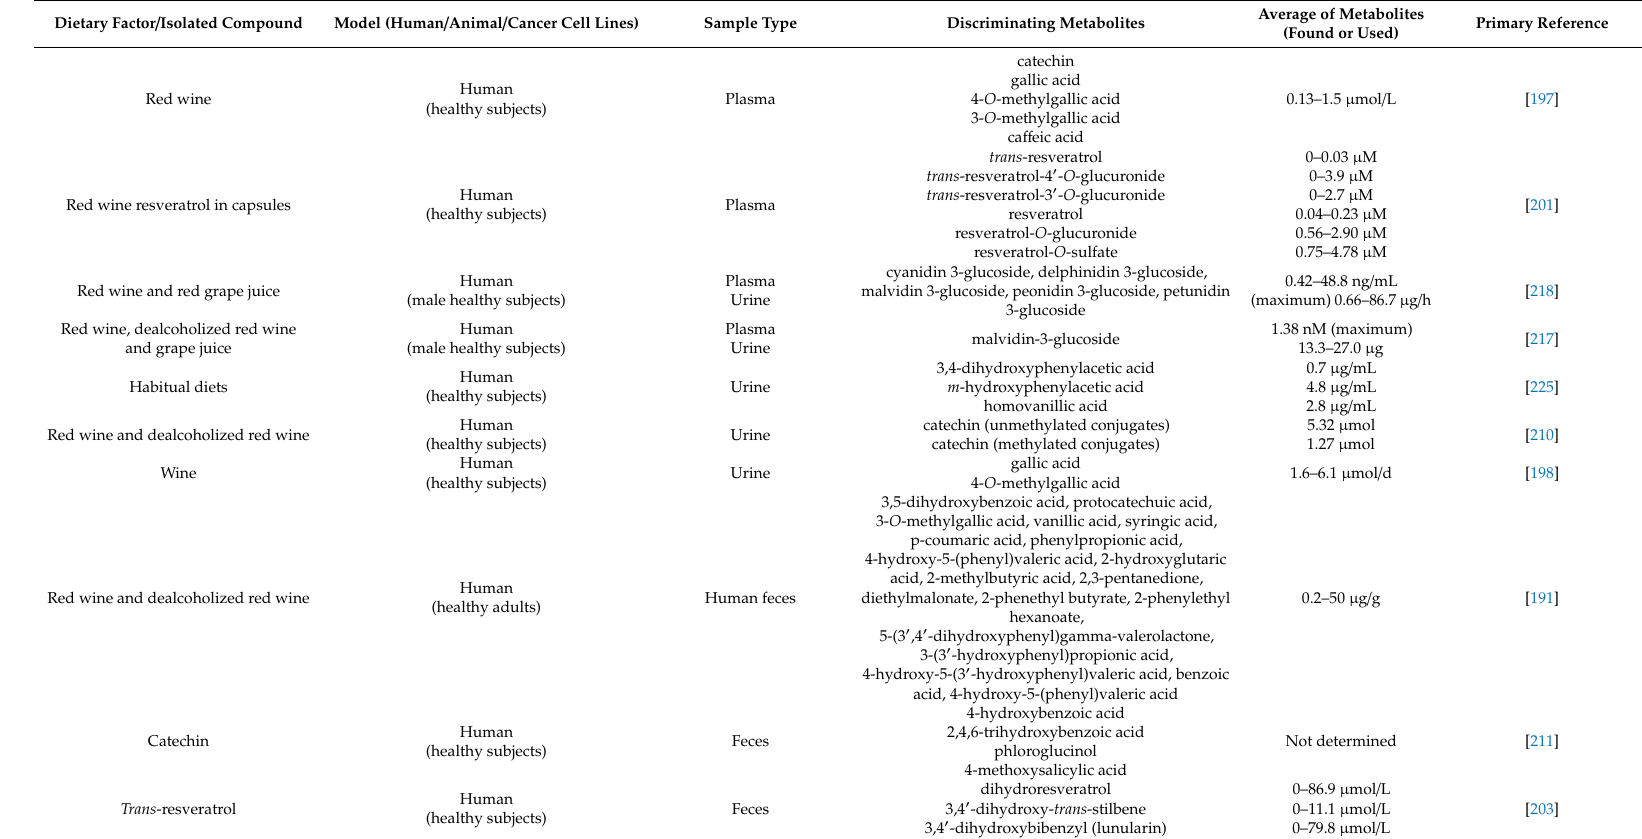
Table 1. Summary of metabolites found or used in di ff erent in vitro and in vivo